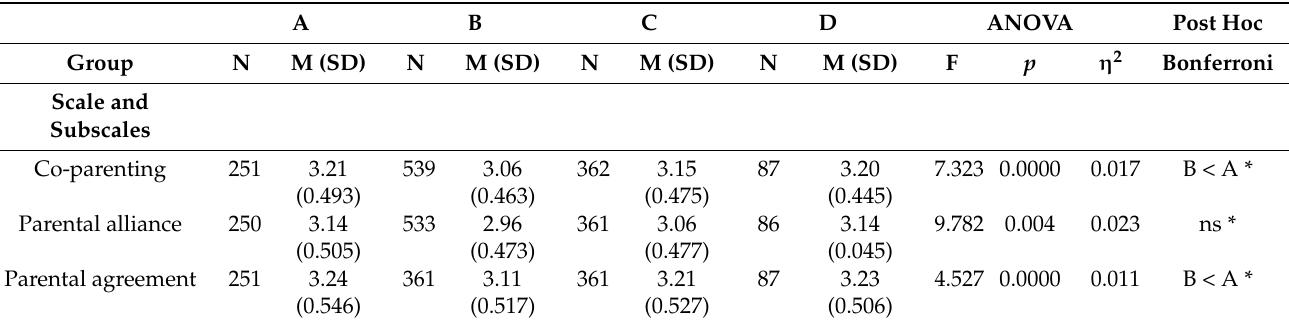
Table 3. Descriptive statistics and analyses of variance for the co-parenting scale and its subscales according to the parents’ employment